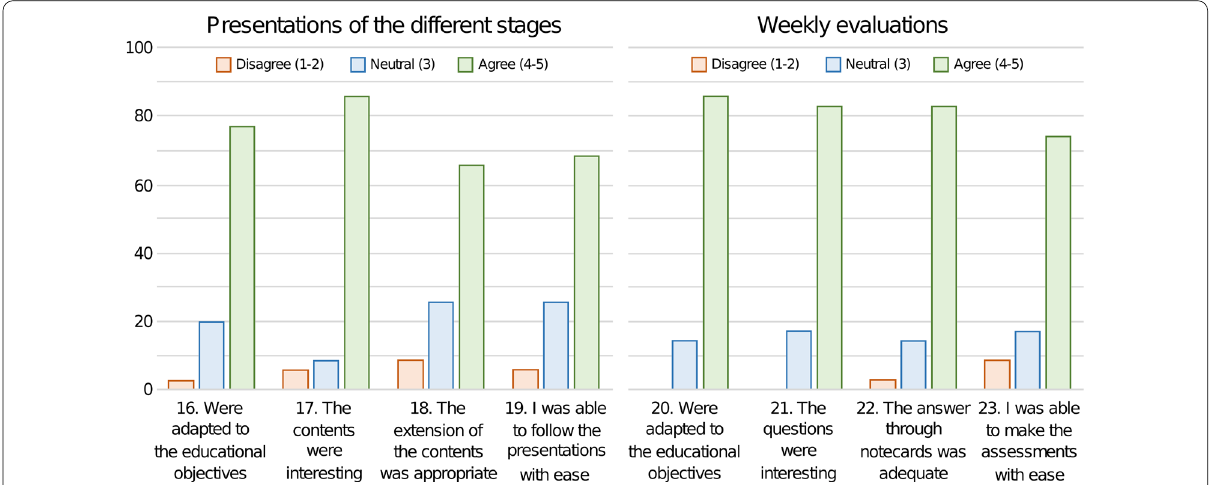
Fig. 7 Bar diagram expressing the results of the evaluation questionnaire on the teaching presentations and the test‑type evaluations of the game on a five‑point Likert scale. The bars express the percentage of students who completely disagreed or disagreed (1–2), gave a neutral answer (3), or agree or completely agree (4–5)